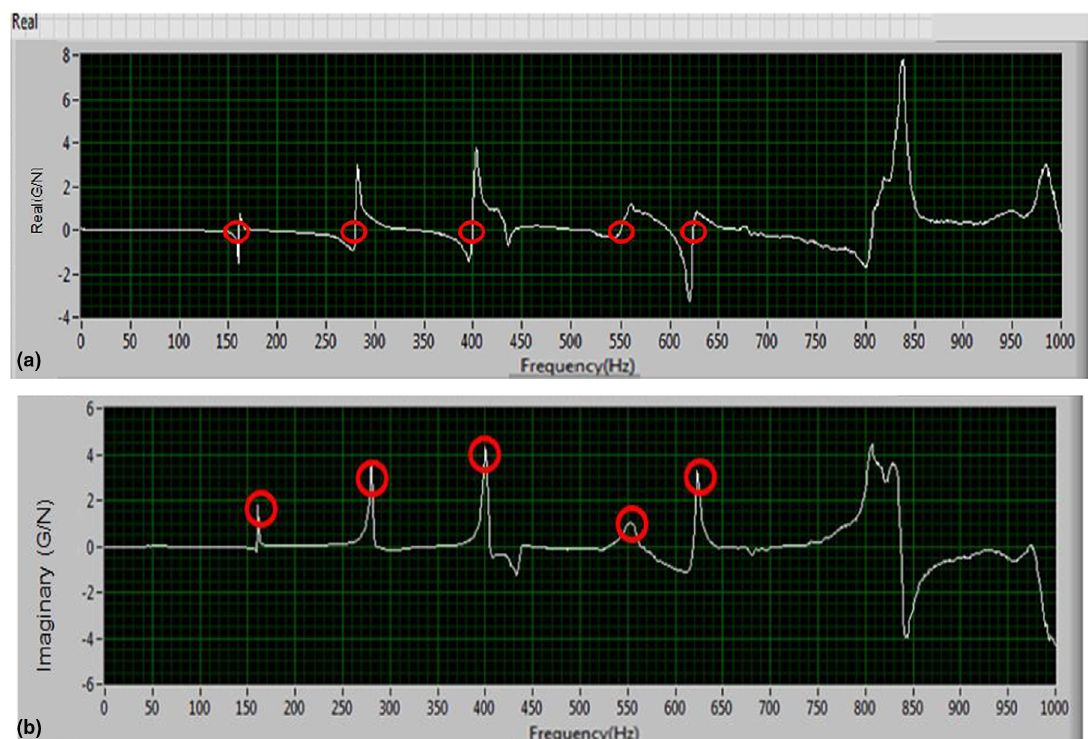
Fig. 13. (a) Real part of FRF indicating the natural frequencies. (b) Imaginary part of FRF indicating the natural